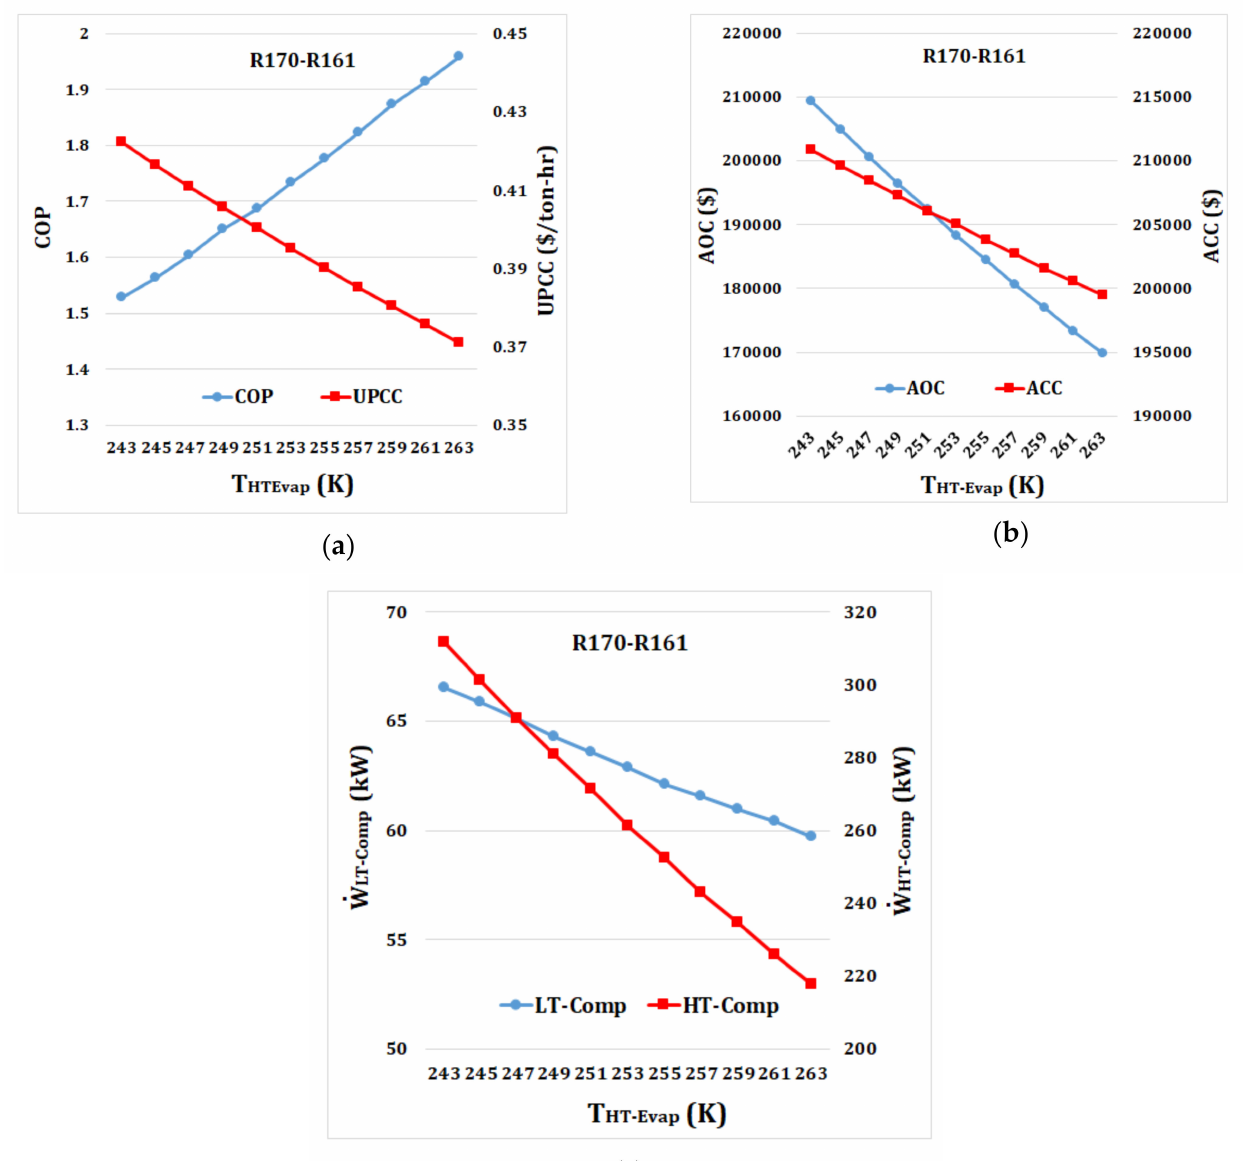
. . W LT − Comp and W HT − Comp of the optimized